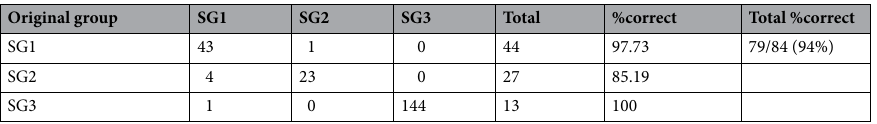
Table 1. Summary results of Canonical analysis of principal coordinates (CAP) analysis for average differences in physicochemical variables among the 11 sites in the three site groups.